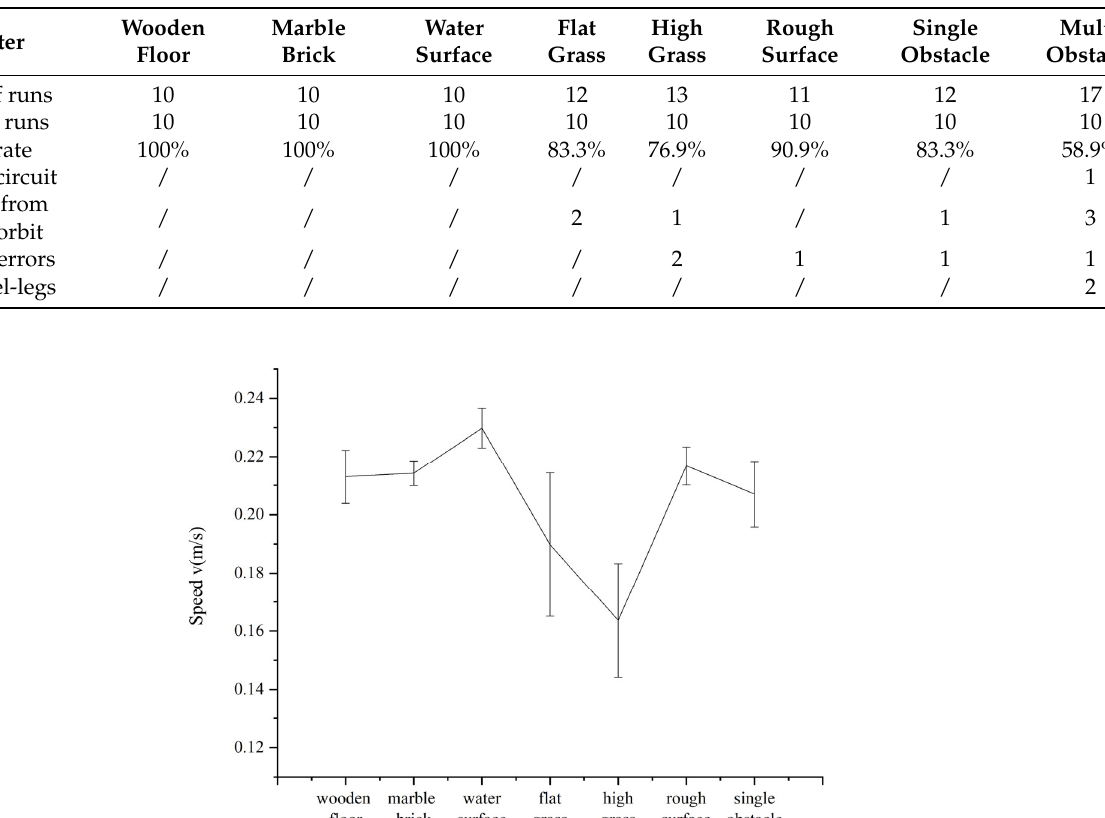
Table 2. Robot straight-line test results on different surfaces.